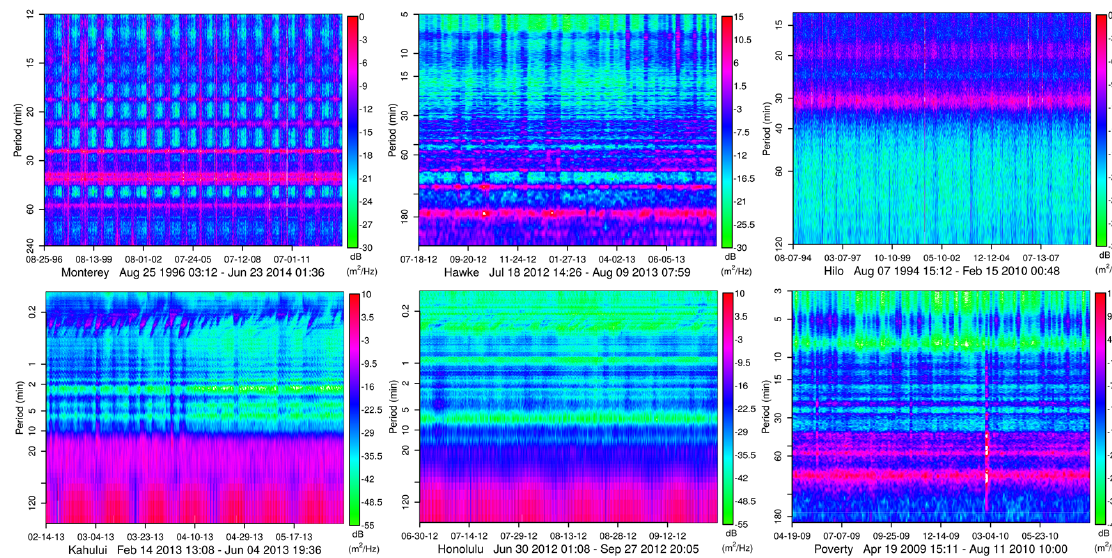
Figure 2. Spectrograms of water level data at each tide gauge. Horizontal bands indicate continuous oscillations, vertical bands are associated with periods of increased wave energy.